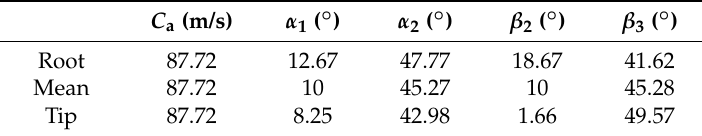
Table 8. Initial angular profile of the stator and rotor blades